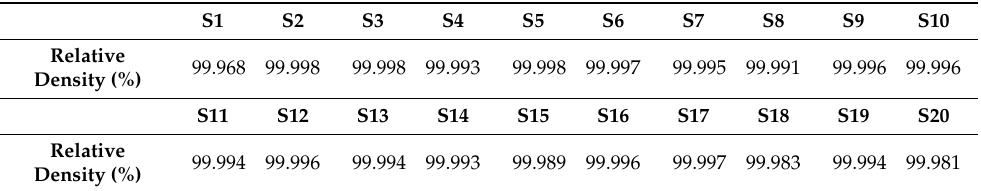
Table 6. Relative density % of cubic samples of FeSi6.5 steel. The density taken as the reference was 7.44 gcm −